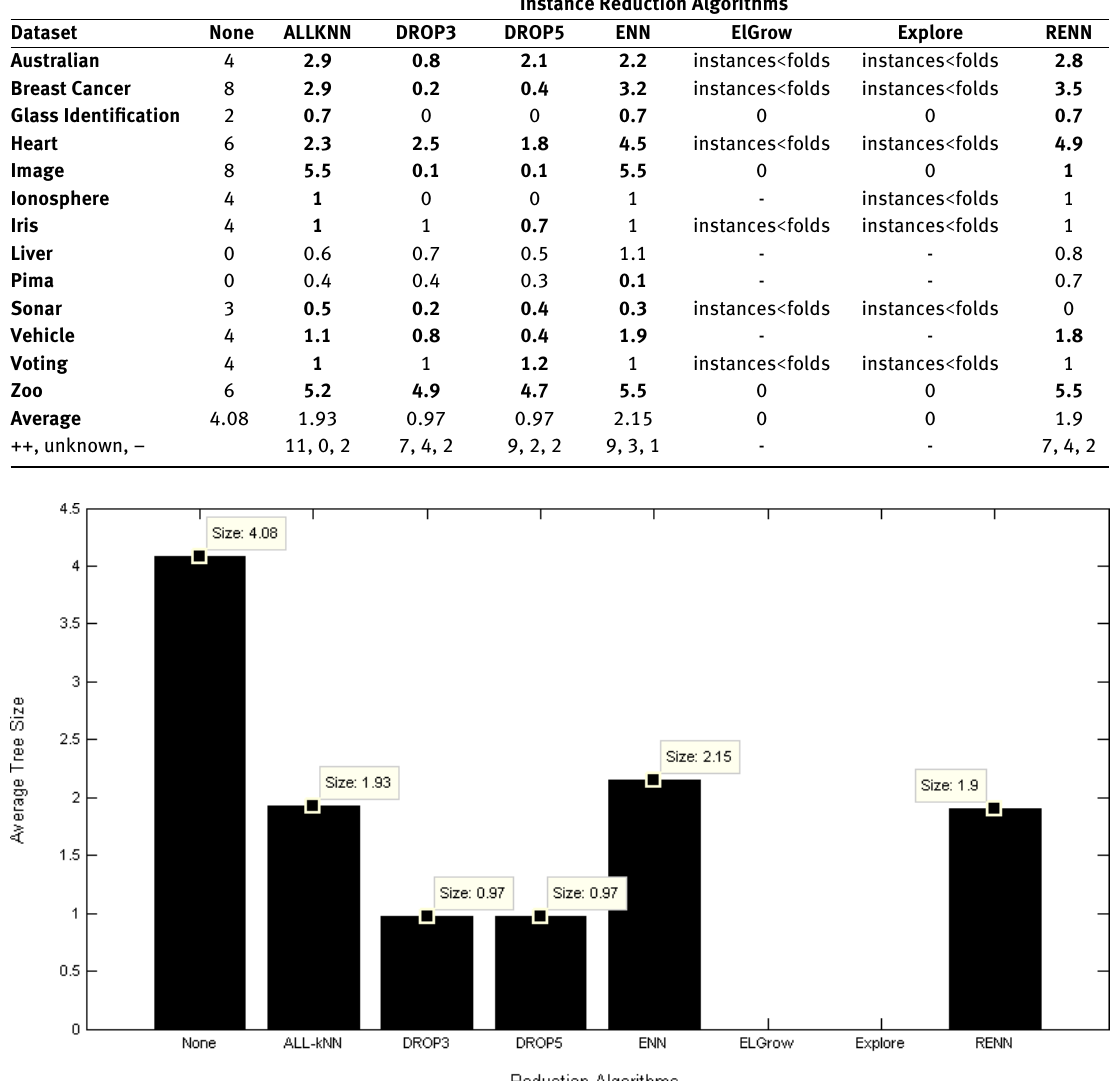
Figure 6: Average Tree Size (Number of Nodes) for Pruned Trees With 0% Noise